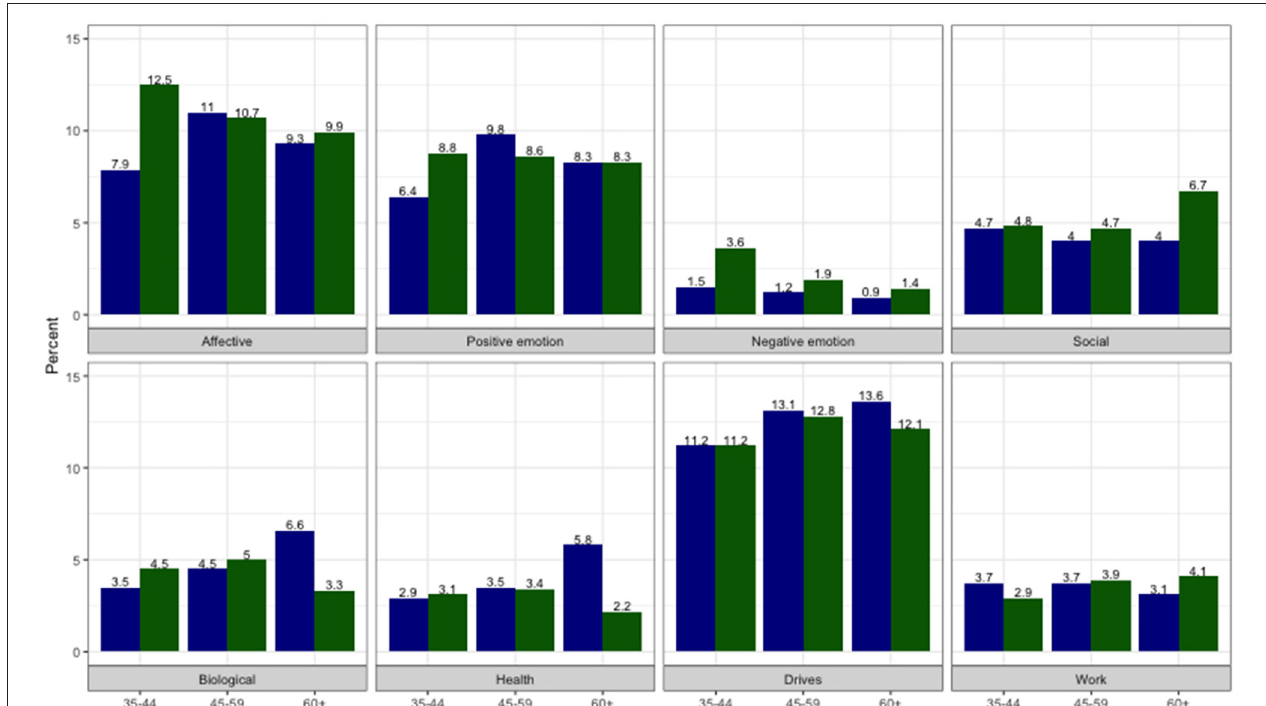
FIGURE 2 | Percent of words classified in different content categories by LIWC libraries by gender and age groups (blue for men and green for women).